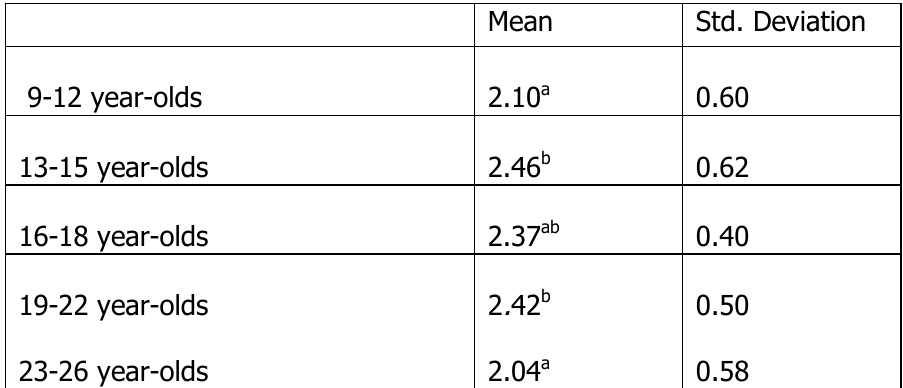
Difference between age groups on imaginary audience ideation